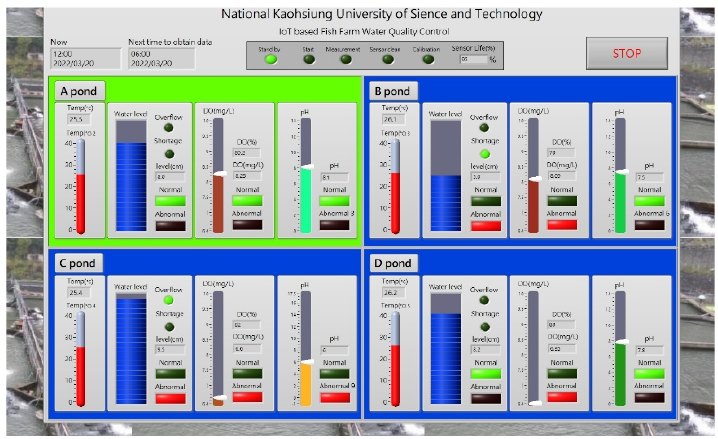
Figure 16. Human–machine interface of intelligent fish farm measurement system.